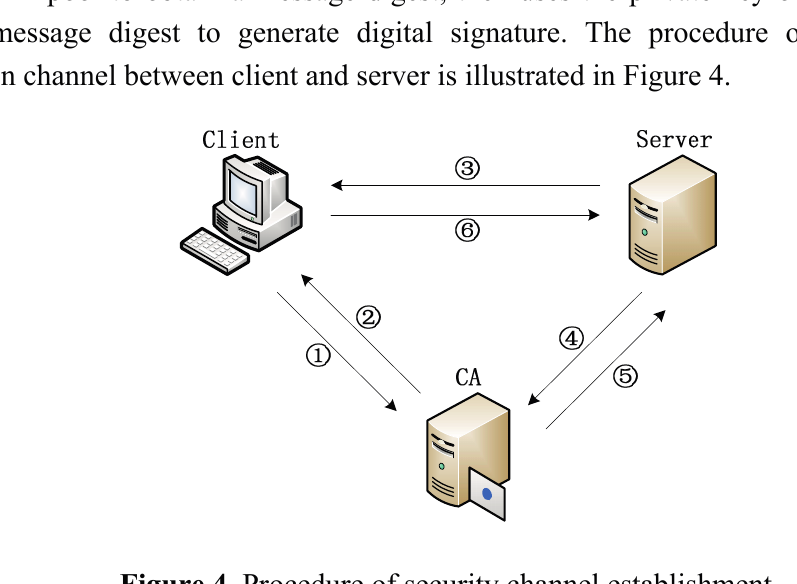
Figure 4. Procedure of security channel